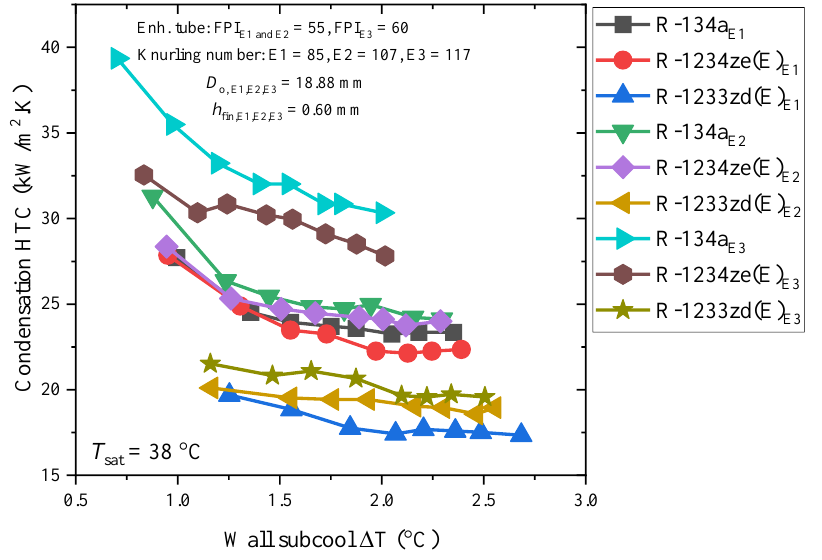
Figure 4. Influence of FPI and knurling number on condensation HTC with R-134a, R-1234ze(E), and R-1233zd(E) Ko and Jeon [9].